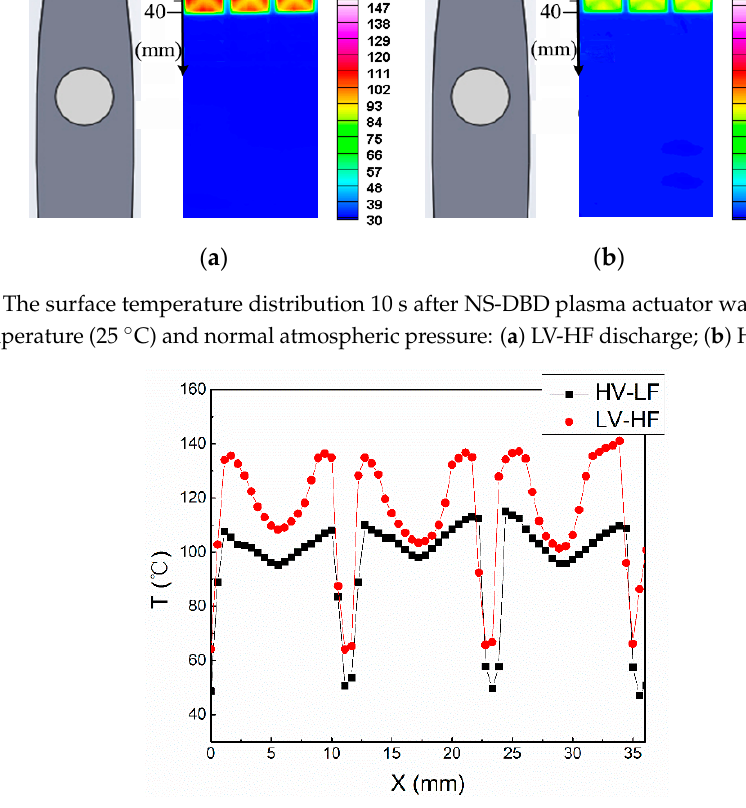
Figure 10. The spanwise (direction of X axis) variation in temperature rise at the location of Y = 20 mm.